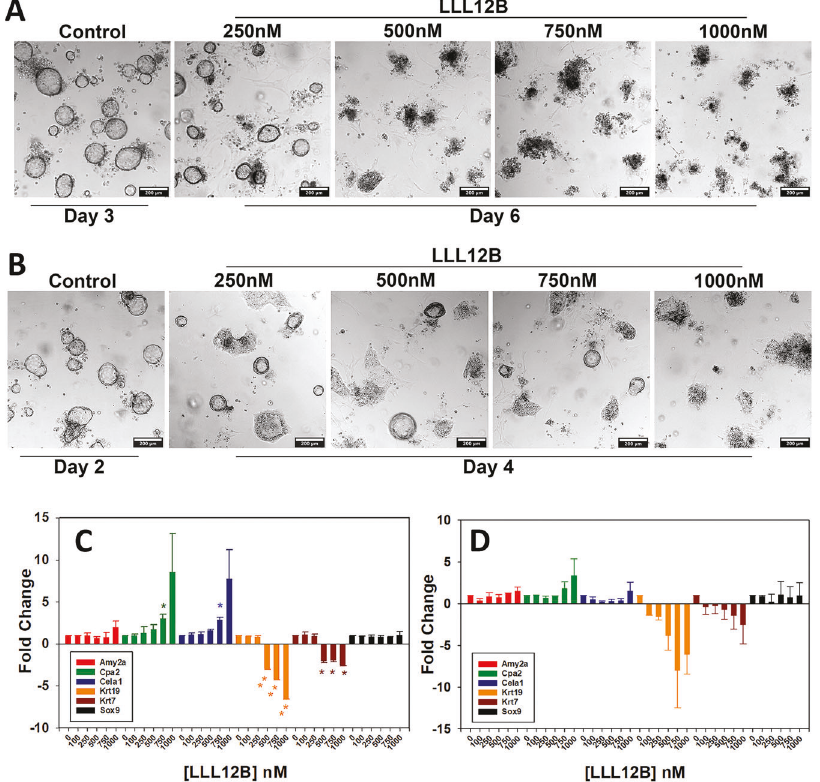
Fig. 3 Reversal of ADM by LLL12B in p48 Cre/ + mouse acini. A p48 Cre/ + mouse pancreatic acini underwent ADM over 3 days of culture and were then exposed to increasing concentrations of LLL12B for 3 additional days. B KC mouse pancreatic acini underwent ADM over 2 days of culture and were then exposed to increasing concentrations of LLL12B for 2 additional days. Expression of acinar and ductal genes from LLL12B treated p48 Cre/ + ( C ) or KC ( D ) mouse pancreatic organoids following the identical treatment as in ( A ) and ( B ), respectively. Data are presented as fold-change normalized to 18S rRNA and relative to the untreated control. Mean ± SD from duplicate experiments. * P < 0.05; ** P <